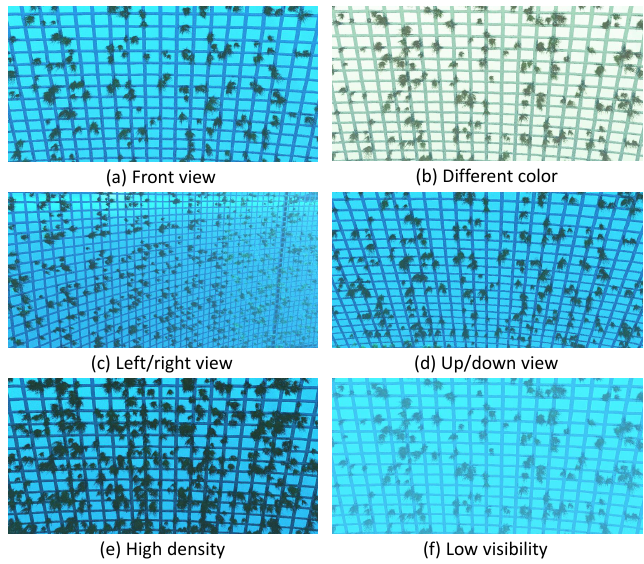
Figure 9. Raw virtual scenes. ( a ) front view; ( b ) different color; ( c ) left/right view; ( d ) up/down view; ( e ) high density of marine growth; and ( f ) low